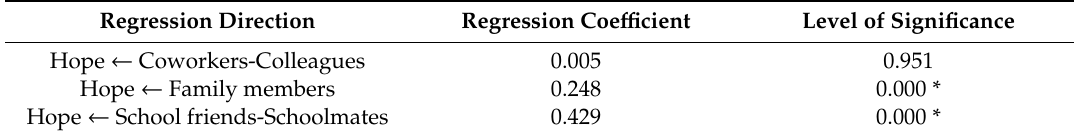
Table 6. Standard regression coe ffi